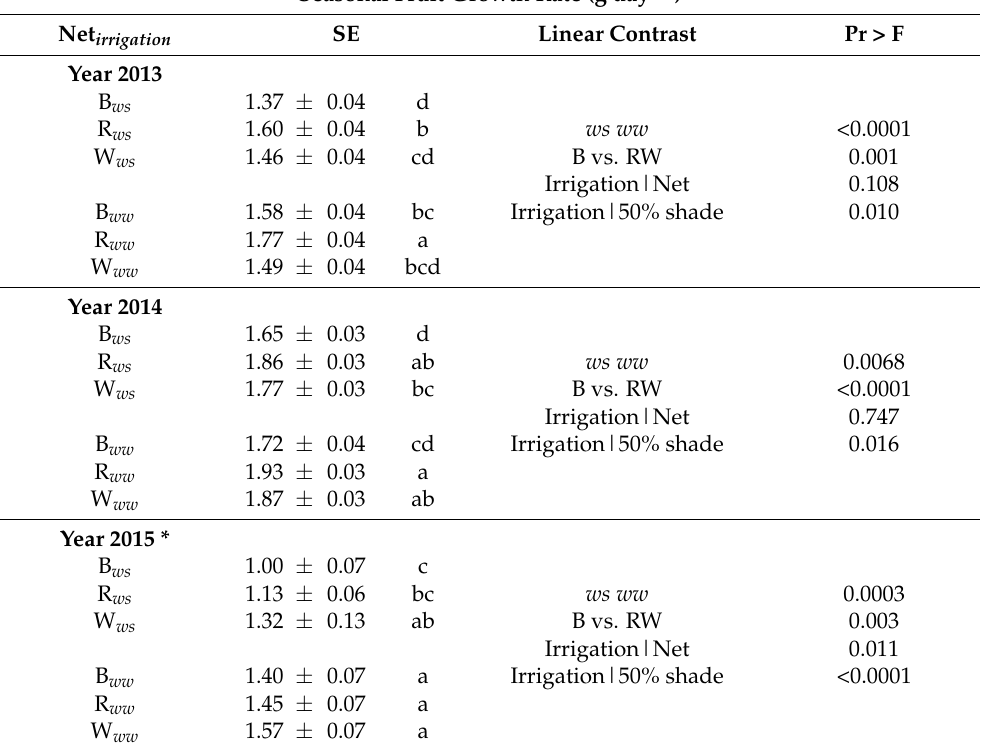
Table 5. Seasonal fruit absolute growth rate (AGR) for net irrigation treatments, during years 2013, 2014 and 2015. The interaction between treatments and crop load was not found to be significant, except in 2015 (*). Thus, for the years 2013 and 2014, each value is the result of a simple ANOVA (mean of 4 trees), whereas in 2015 each value is the LS mean of an ANCOVA (mean of 4 trees). Means, on the left side, are followed by standard error. Different letters indicate significant differences at p < 0.05. On the right side of the table, linear contrast F values for each year are shown; values below 0.05 are considered